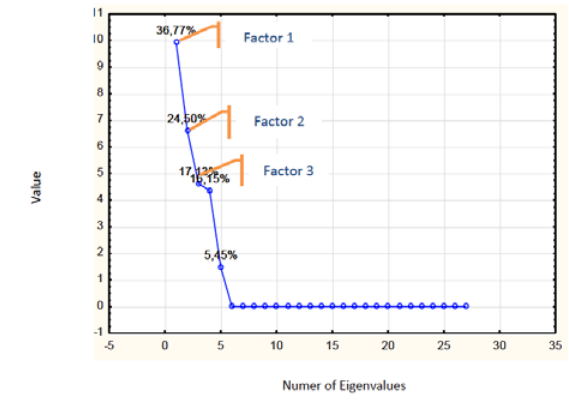
Figure 3: Factorial scree